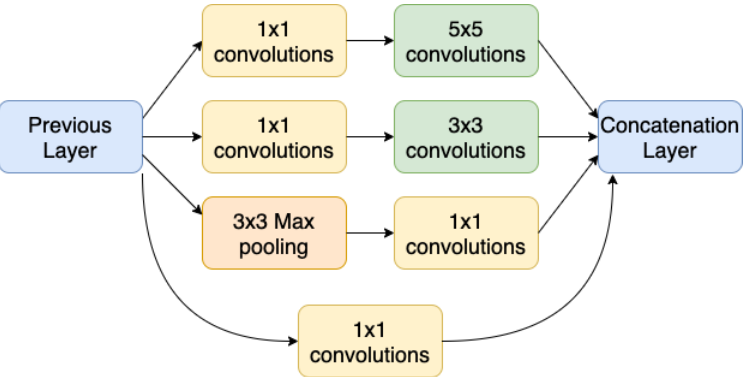
Figure 2. Inception